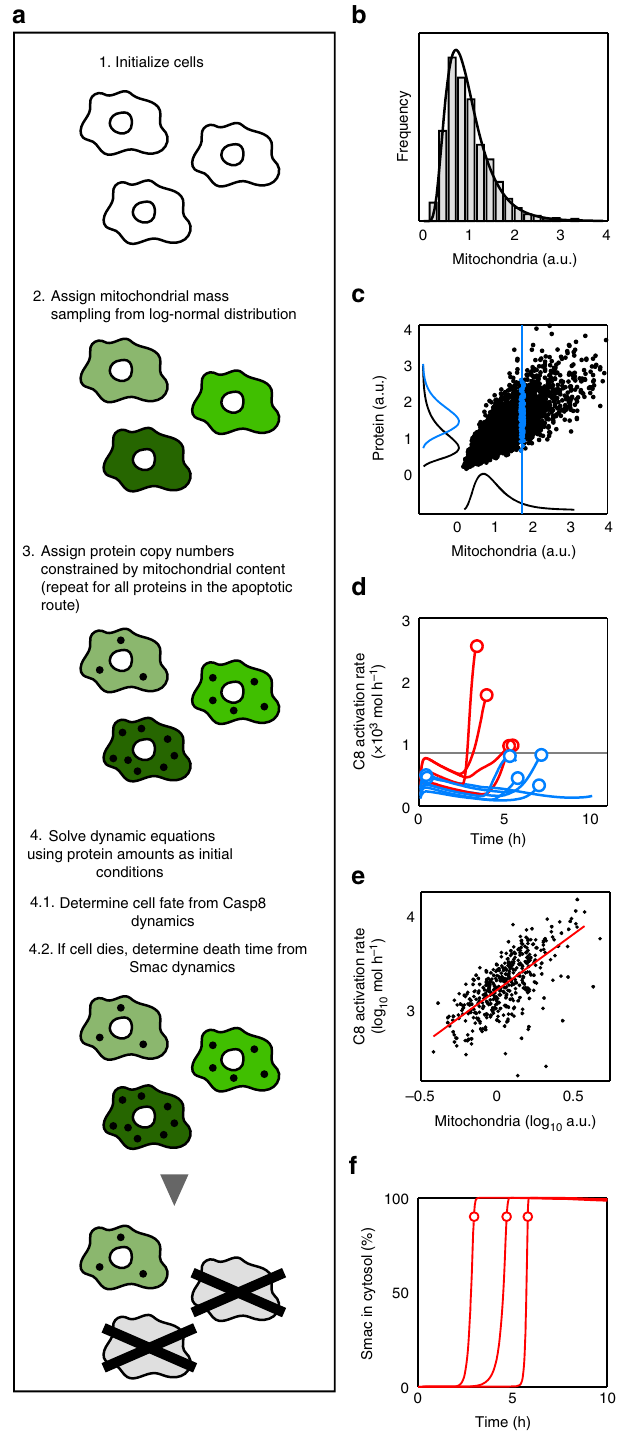
Fig. 4 Computational model work fl ow and key modelling aspects. a Computational model work fl ow. b Distribution of mitochondrial levels. We initialise a population of cells with heterogeneous mitochondrial levels sampling from a log-normal distribution of mean and width obtained from the experimental CMXRos distribution. c Sampling of initial protein levels. For each protein in the apoptotic pathway, we assign to every cell a protein copy number conditioned by its mitochondrial level. The black line along the vertical axis represents the total protein distribution and the blue line, the protein distribution conditioned by the indicated mitochondrial value (vertical blue line). d Casp8 activation rate. The decision about the cell fate (death/life) is de fi ned by a threshold (horizontal black line) in the rate of Casp8 activation. Cells with maximum activation rates (circles) below the threshold (blue trajectories) are considered as survivors whereas cells that overcome the activation threshold (red lines and circles) are assumed to die after MOMP. e Casp8 maximum activation rate depends on the cell mitochondrial content. Each black dot is a simulated cell (only cells that undergo MOMP before 24 h are shown). The regression line is shown in red. f Smac dynamics. Time to death is de fi ned as the time at which cytosolic Smac reaches 90% of its maximum